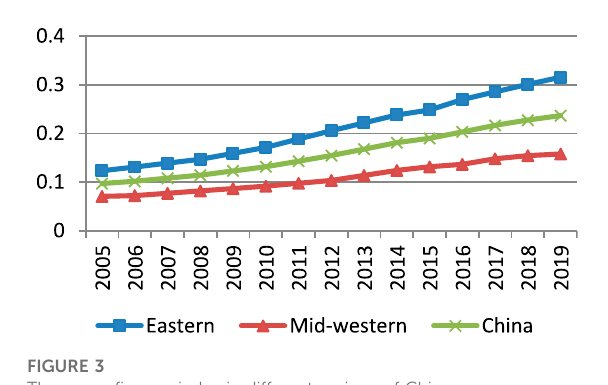
FIGURE 3 The green fi nance index in different regions of